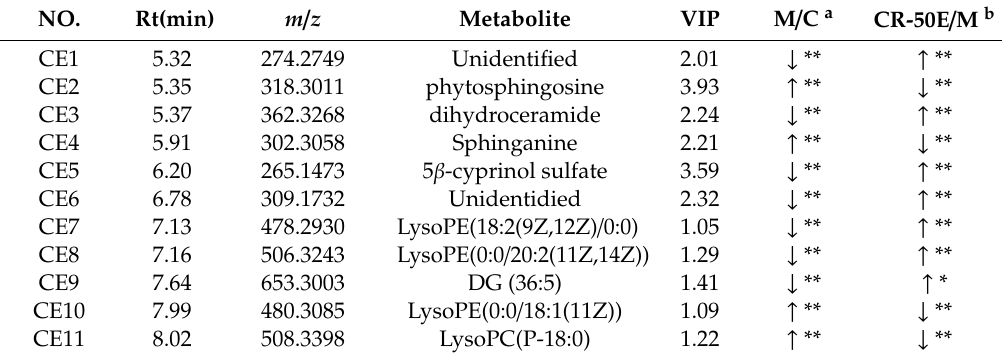
Table 1. The variation tendencies of the 11 altered variables related to the lesion in corticosterone treated PC12 cells after CR-50E treatment